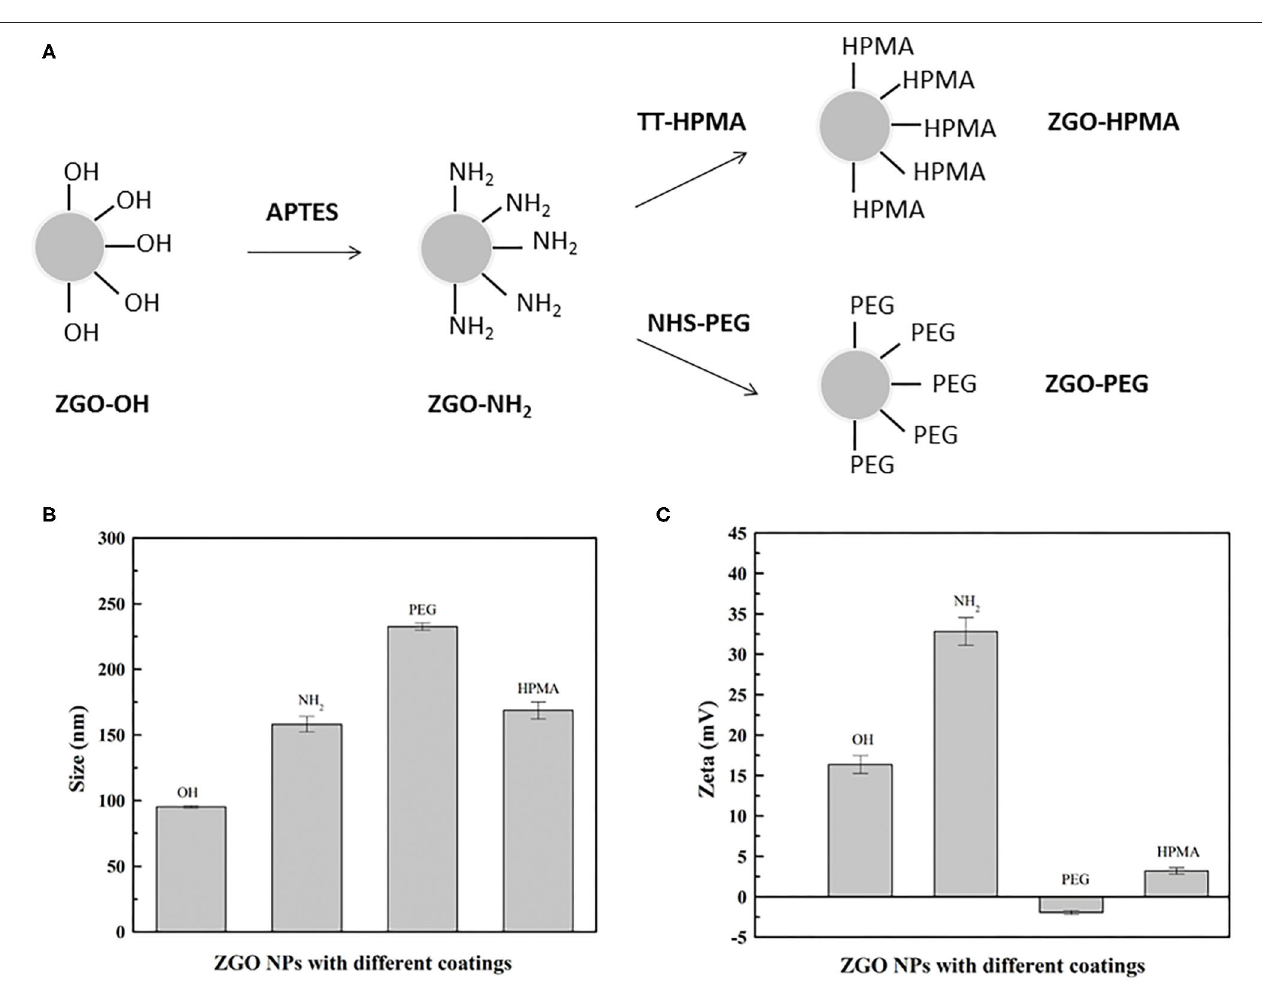
FIGURE 3 | Coating of ZGO NPs. (A) Principle of ZGO coating with HPMA and PEG. (B) DLS of coated NPs. (C) Zeta potential of coated NPs.